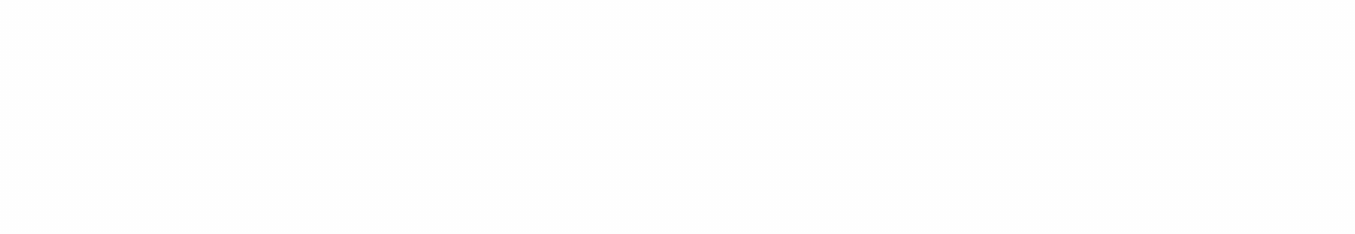
FIGURE 4 Power spectrum of the velocity correlation func- tion for vi 0.8. The main peak corresponds to the frequency of the collective movement of the agents.